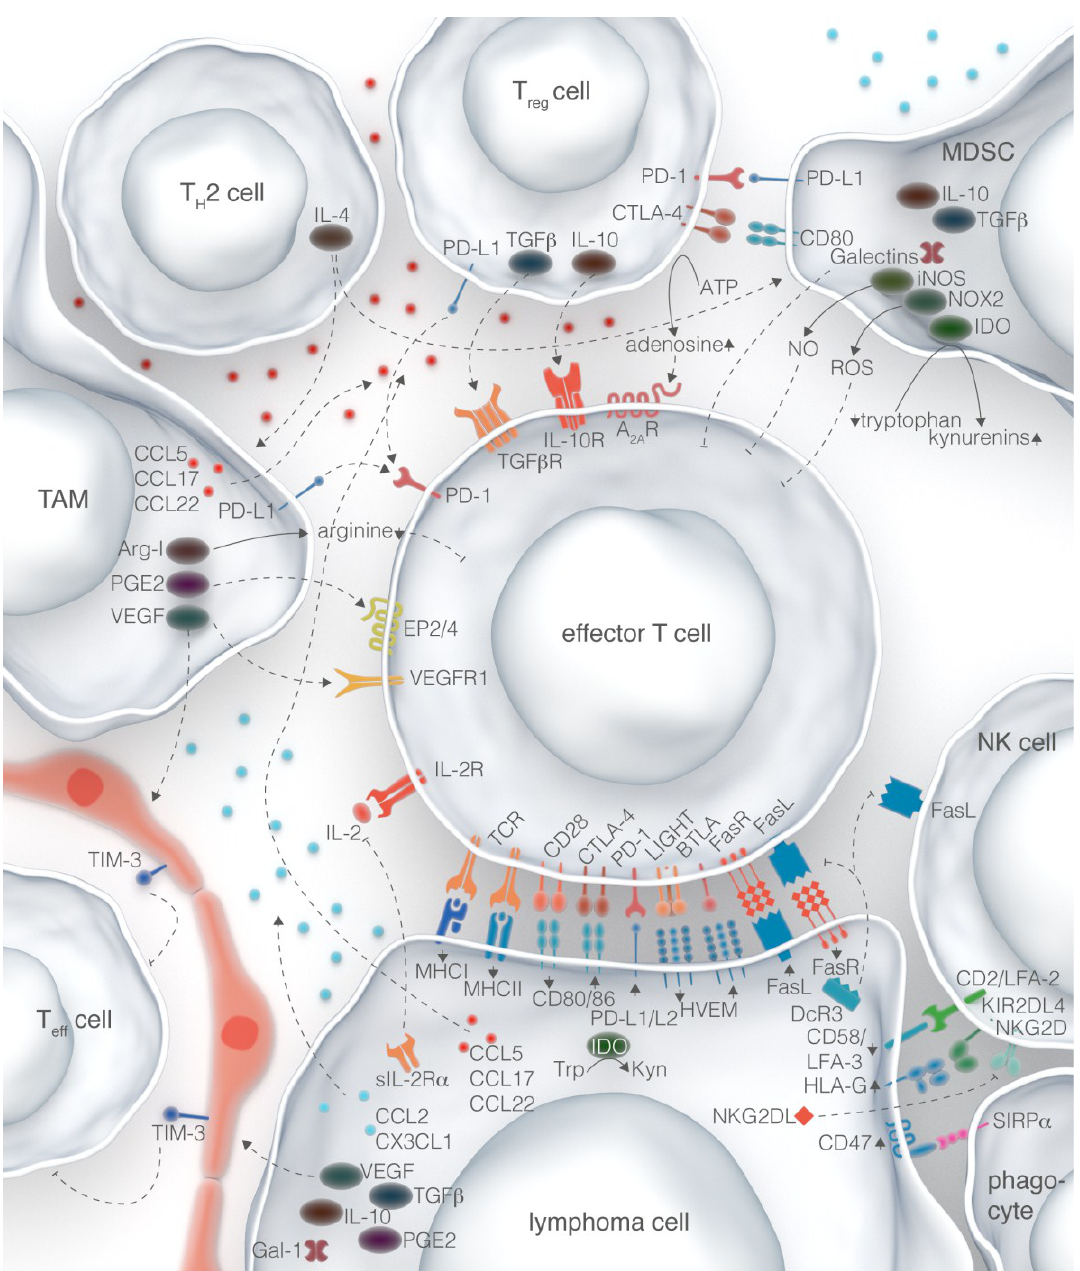
Figure 1. Immune evasion mechanisms in the lymphoma microenvironment. Lymphoma cells can suppress anti-tumor immune cells (e.g., effector T cells, NK cells, and phagocytes) directly through surface-mediated mechanisms as well as secreted factors. Chemokines expressed by the lymphoma cell can also recruit regulatory cells (e.g., tumor-associated macrophages, myeloid-derived suppressor cells, Tregs, and Th2-polarized cells) that form a complex network of interactions to maintain a tolerogenic microenvironment and allow the lymphoma cell to escape